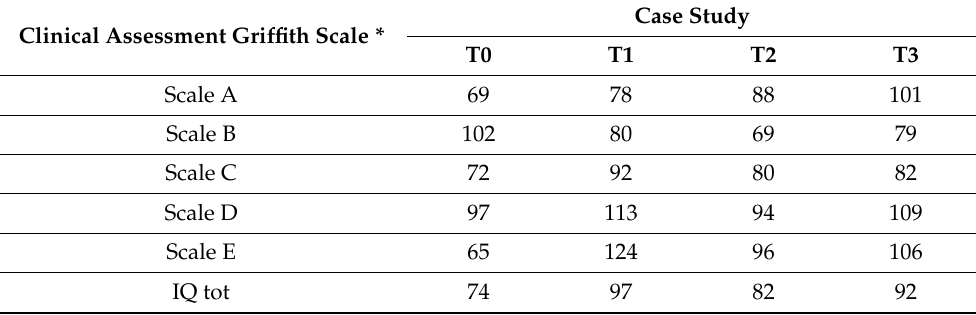
Table 1. Clinical assessment. Total score of neuropsychological and psychological assessment before and during rehabilitative training. T0 (baseline); T1 (12 months after T0); T2 (6 months after T1); T3 (12 months after T1).